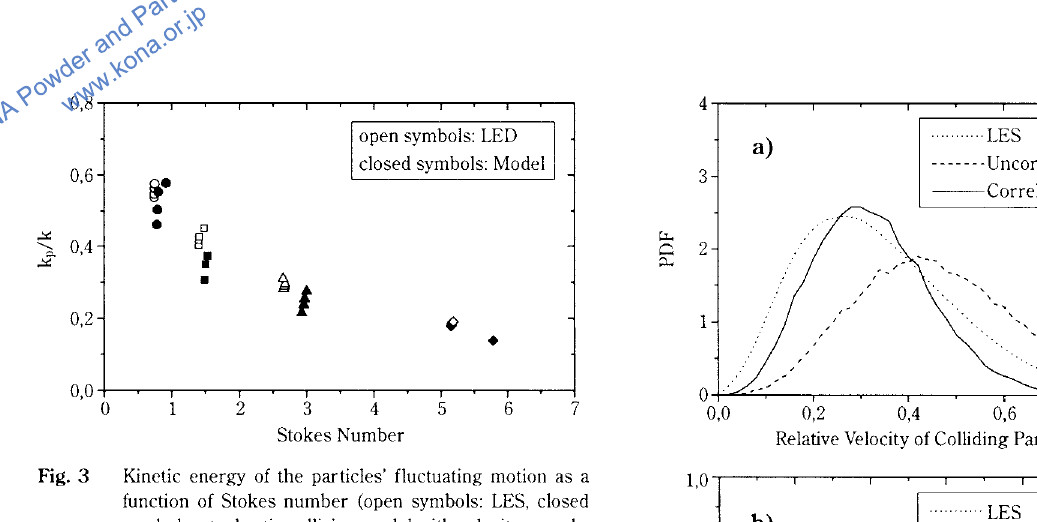
Fig. 3 Kinetic energy of the particles' fluctuating motion as a function of Stokes number (open symbols: LES, closed symbols: stochastic collision model with velocity correla tion, symbols of one kind indicate the results for the different volume fractions (see Table 1)) relative velocity distribution function (PDF) for parti cles with a Stokes number of 0. 794, shown in Fig. 4a), reveals the importance of accounting for this correla